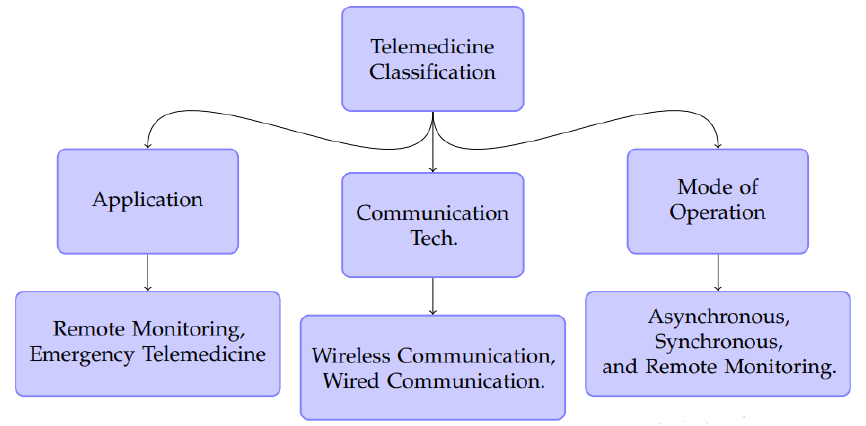
Figure 6. General classification of Telemedicine.